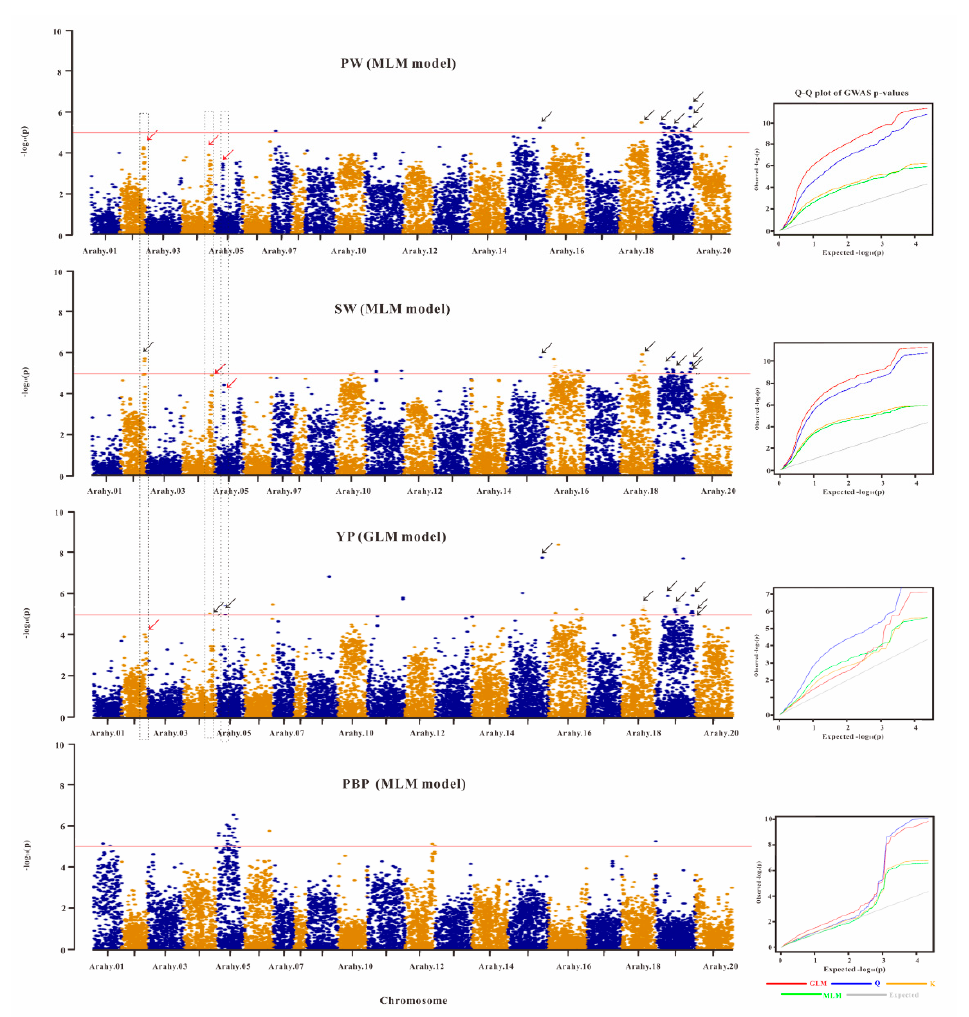
Figure 4. Manhattan plots showing the associations of all SNPs with four yield-related traits. The four yield-related traits are, respectively, hundred-pod weight (PW), hundred-seed weight (SW), yield per plant (YP), and pod branch number per plant (PBP). For each trait, the Q–Q plots from four different statistical models are also shown in the right. The shown Manhattan plots are from the best statistical models (according to Q–Q plots). On chromosomes Arahy.15, Arahy.18, and Arahy.19, there are, respectively, one, one, and five SNPs (see the black arrows in these regions) that are associated with PW, SW, and YP. On chromosomes Arahy.02, Arahy.04 and Arahy.05, the dashed blocks enclose, respectively, one SNP cluster where the top SNP is significantly (black arrow) or not significantly (red arrow) associated with traits SW, PW, and YP. The significance level is log10 (0.05 / 13435) = 5.3 (the red horizontal